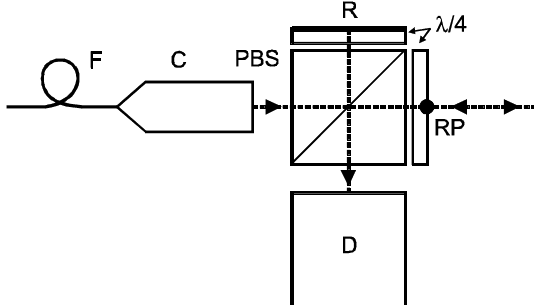
Figure 4. Schematics of the single-pass interferometer with a plane mirror reflector. PBS: polarizing beam splitter, C: collimator,  /4: retardation plate, D: detection unit, F: optical fiber, R: reflective surface, RP: reference